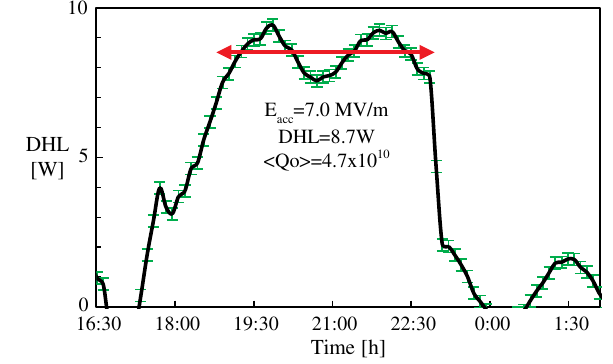
¼ 7 . 0 MV = m at 1.8 K after second fast acc ¼ 0 MV = m was DHL ¼ 0 ½ W (cid:3) . acc